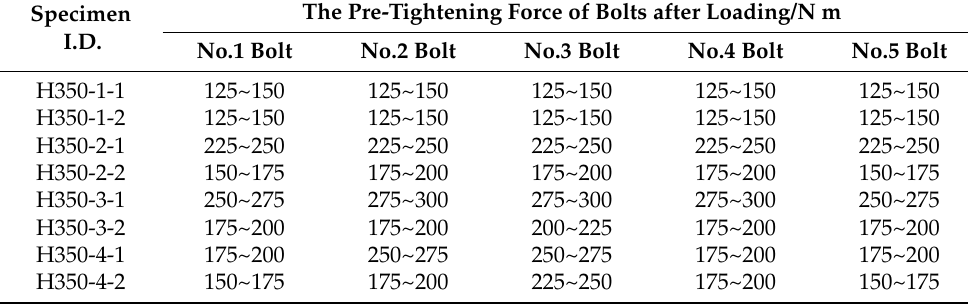
Table 4. Pre-tightening force loss of connecting high-strength